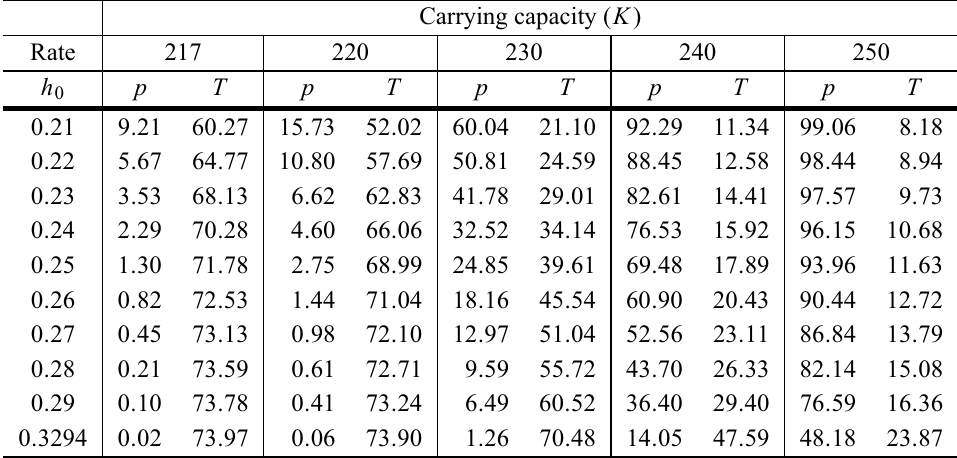
Indicators estimates via Monte Carlo simulation.